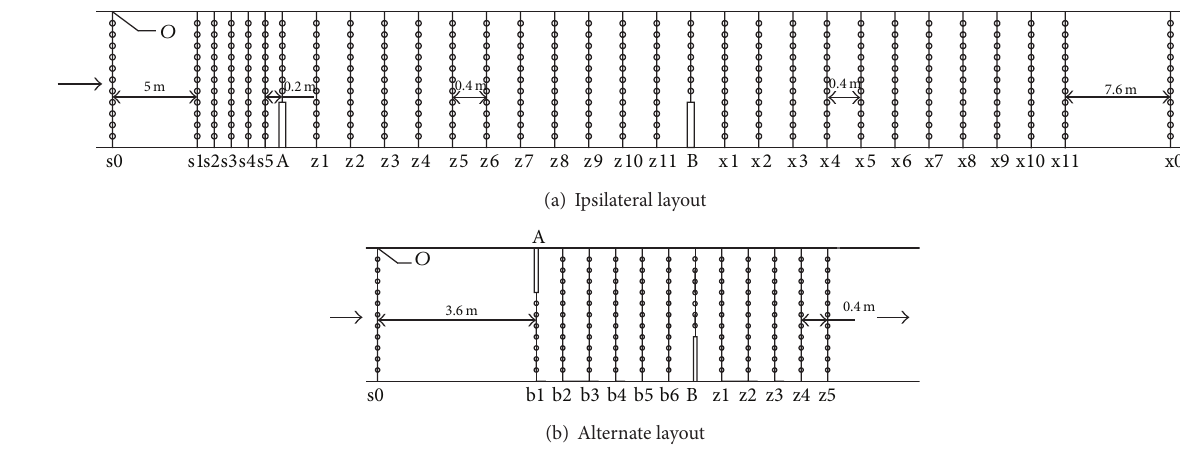
Figure 2: Spur dike layouts, monitoring cross sections, and monitoring